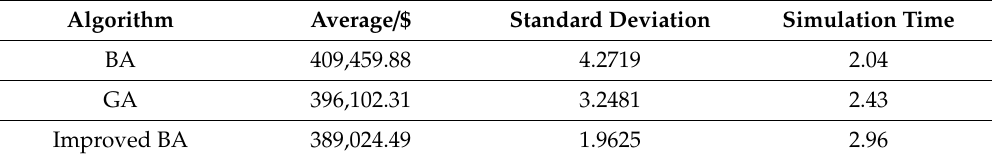
Table 3. Performance comparison of BA and improved